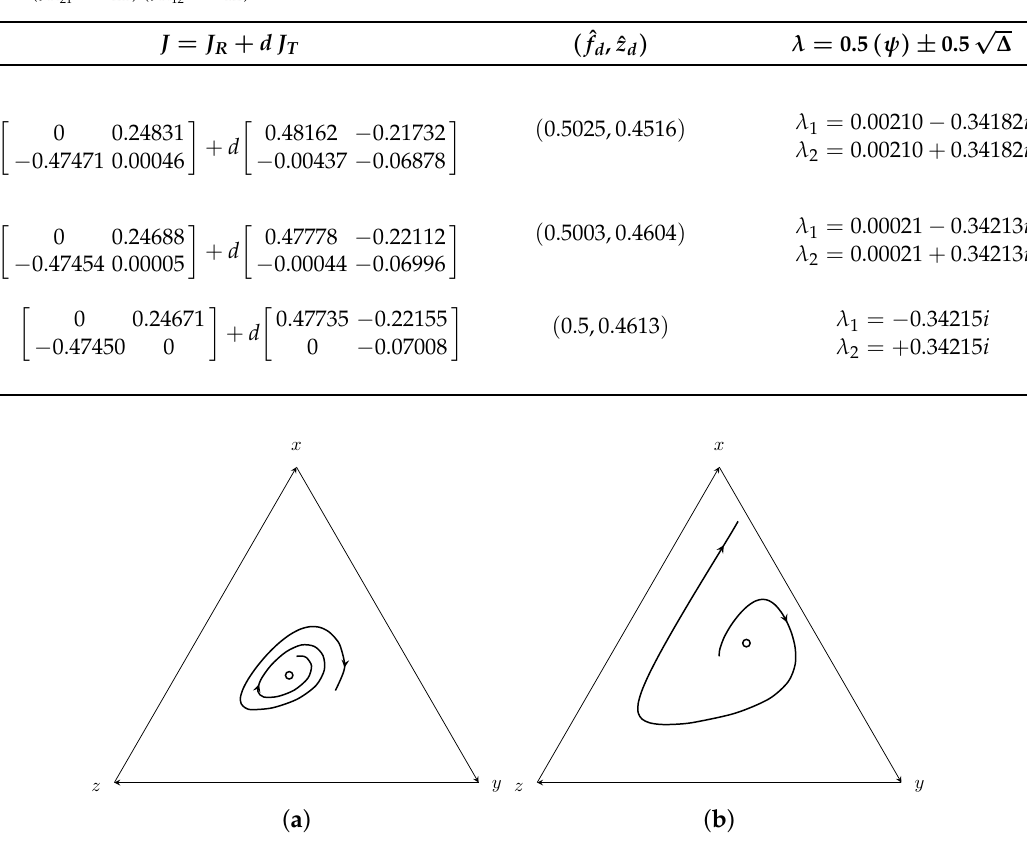
ε 22 + ε 11 and ∆ = 22 −